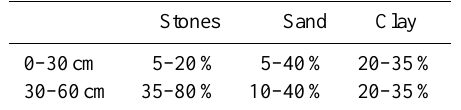
Table 2. Fractions of stones, sand, clay for typical spur and foots- lope soils at 0–30cm depth. Sand and clay values exclude the coarse fraction.